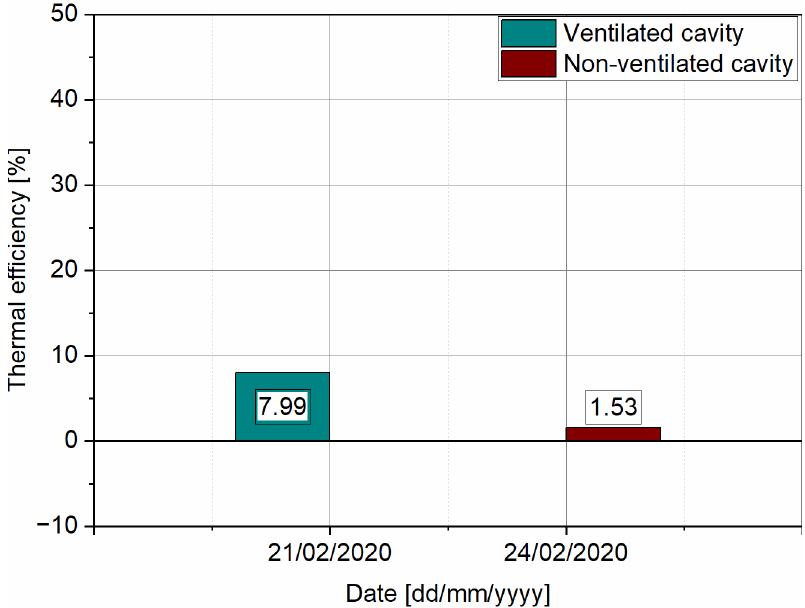
Figure 14. BIPV-WS thermal efficiency behavior for winter conditions.